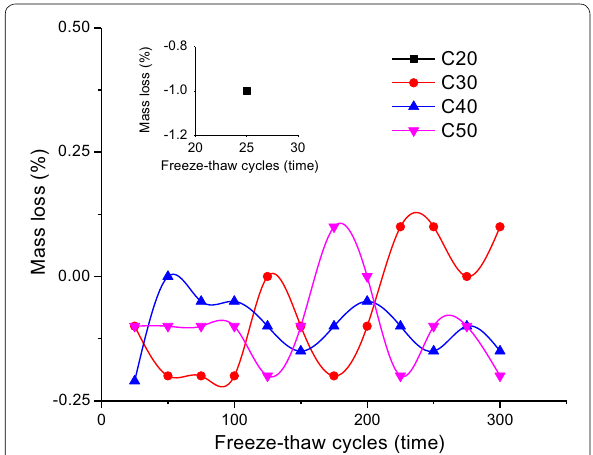
Fig. 11 Mass loss under freeze–thaw cycles.